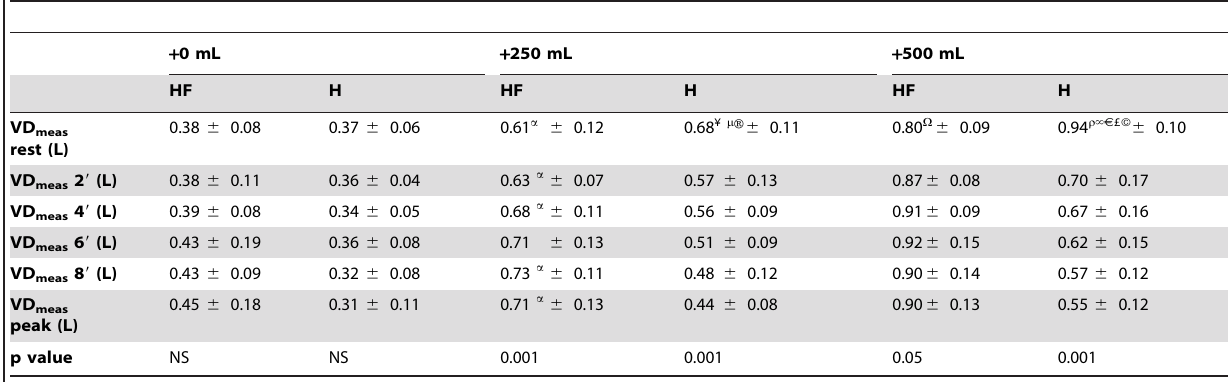
Table 5. Values of volume of dead space at rest and during exercise in heart failure patients and healthy subjects with no additional dead space and with 250 mL and 500 mL of additional dead space.